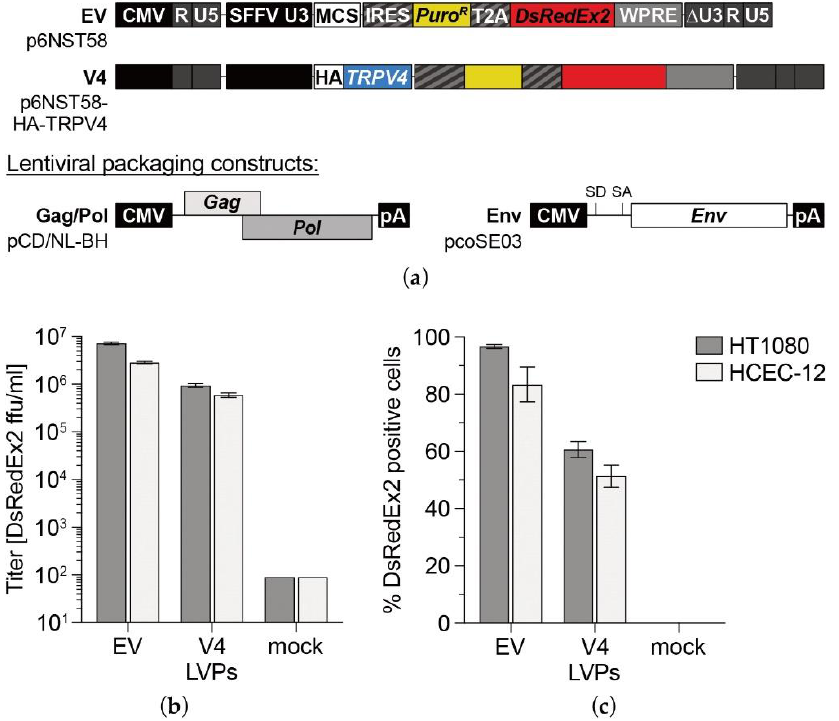
Figure 1. Transduction efficiency of LVPs produced in target cells. Schematic outline ( a ) of the structural organization of lentiviral transfer vectors based on p6NST58 and packaging components (Gag/Pol and Env) for LVP production. Infectious titers [DsRedEx2 ffu/mL] of LVPs ( b ) and percentage of DsRedEx2 positive cells ( c ) as determined by FACS analysis of transduction efficiency in HCEC-12 and the transduction control cell line HT1080. Both cell lines were infected with different dilutions of viral particles containing HEK293T cell culture supernatants. At 3 days post infection (dpi), cells were analyzed by marker gene transfer assay, and titers were calculated. Mean ± SEM from n = 3. EV: empty vector LVPs, V4: TRPV4 sequence-carrying LVPs, mock: LVP-free supernatant of pUC19-transfected HEK293T.